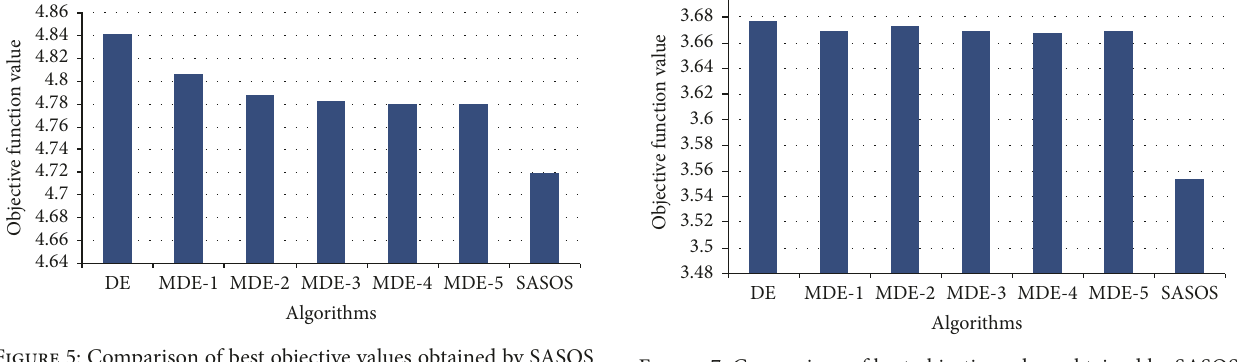
Figure 7: Comparison of best objective values obtained by SASOS algorithm with DE and its modified versions for 4-bus